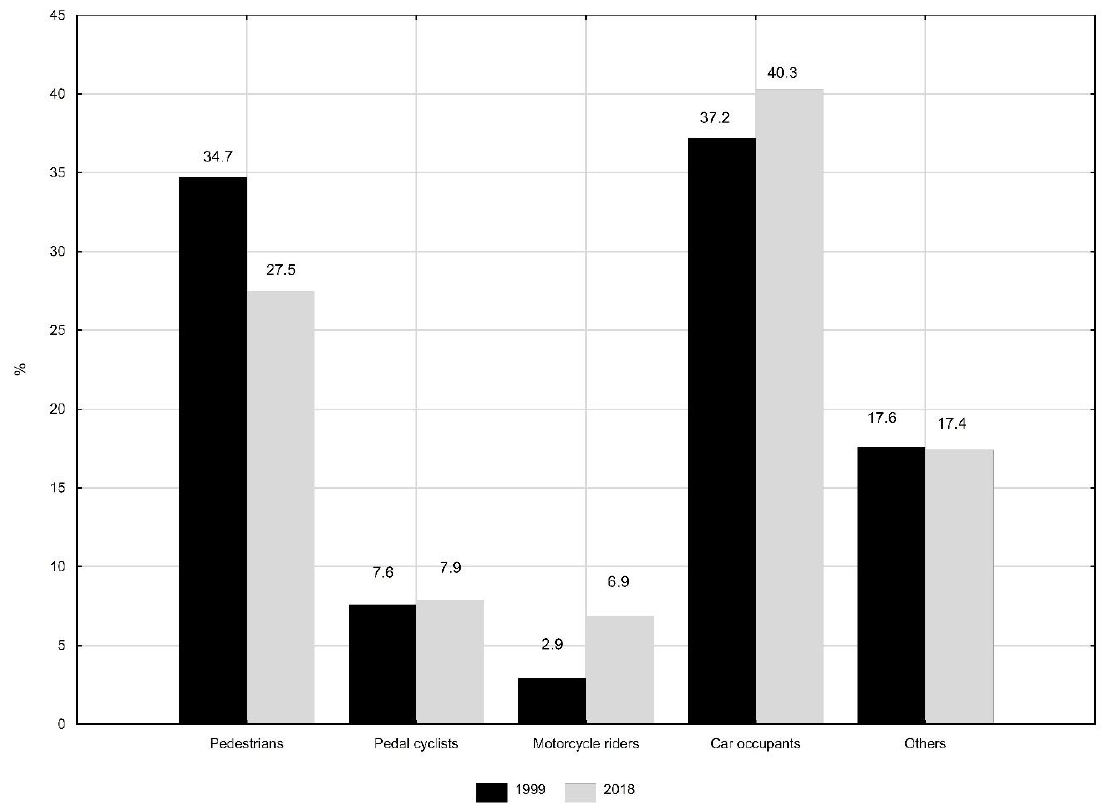
Figure 1. Structure of deaths due to traffic accidents by causes (%). Source: own calculations. The second most common group included deaths due to pedestrians injured in transport accidents. However, the percentage value decreased over the analyzed 20 years from 34.7% to 27.5%. The mortality related to motorbike rider injuries increased from 2.9% in 1999 to 6.9% in 2018. The proportion of deaths due to pedal cyclist injuries remained similar (7.6% and 7.9%, respectively).